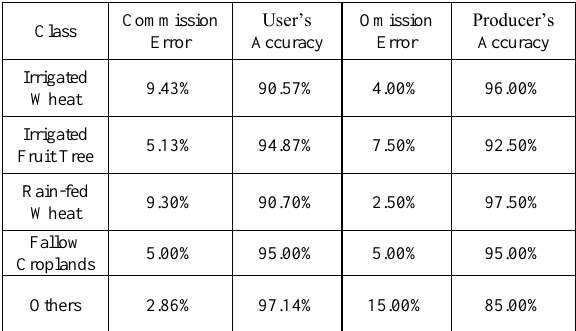
Table 1. Accuracy assessment by ground-truth